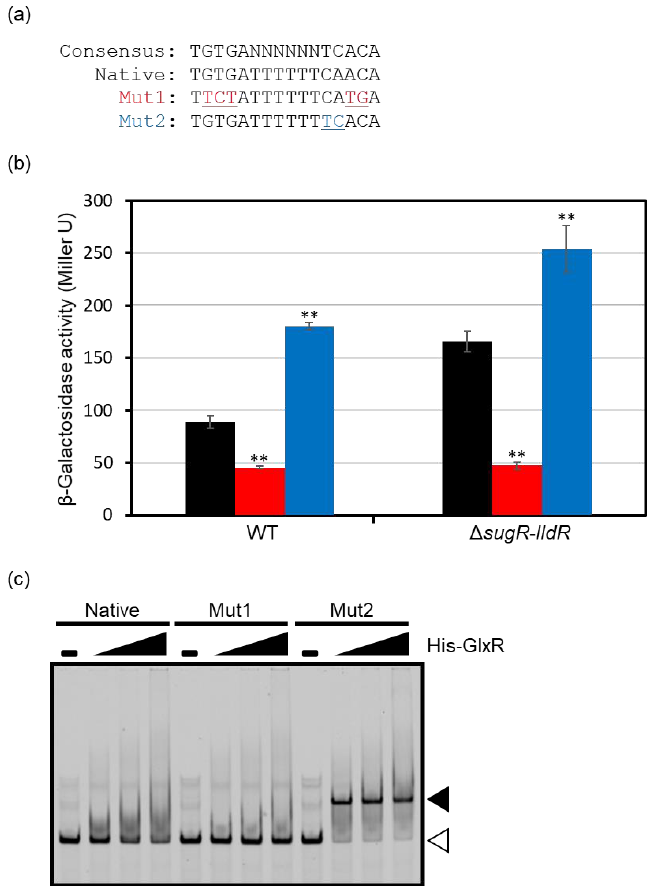
Figure 3. Effects of mutations in the GlxR-binding site. ( a ) Mutations introduced into the GlxR-binding site in the ldhA promoter. Consensus binding site (top) is shown for reference. The mutation mut1 was designed to exchange highly conserved nucleotides, and the mutation mut2 was designed to create the consensus site. ( b ) Promoter activity of the lacZ fusions with the ldhA promoter carrying the native (black), mut1 (red), or mut2 (blue) GlxR-binding site in either the wild type or sugR – lldR double deletion mutant. Overnight culture of each strain in A medium supplemented with 4% glucose was used for the LacZ assay. Mean values with standard deviations from more than four clones are shown. p -values were calculated using an unpaired t -test. (**) p < 0.01 (comparison with the native constructs). ( c ) Electrophoretic mobility shift assay using His-tagged GlxR. The Cy3-labeled probes (10 nM) encompassing the ldhA promoter region used for the construction of the lacZ fusions were incubated with varying amounts of His-tagged GlxR: 0.5, 1.0, and 2.0 μM. Free DNA probe and DNA–protein complex are indicated with white and black arrowheads. The probes contain nonspecific bands.